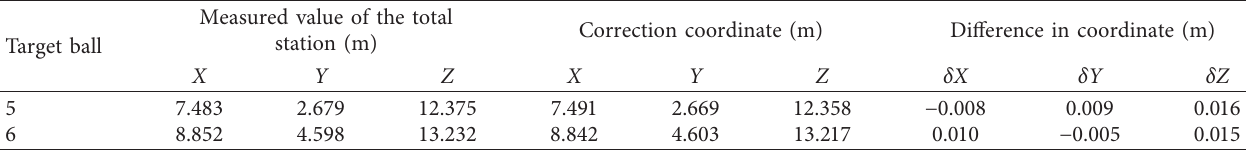
Table 6: The difference between real coordinates and transformed coordinates using the inner parameter.